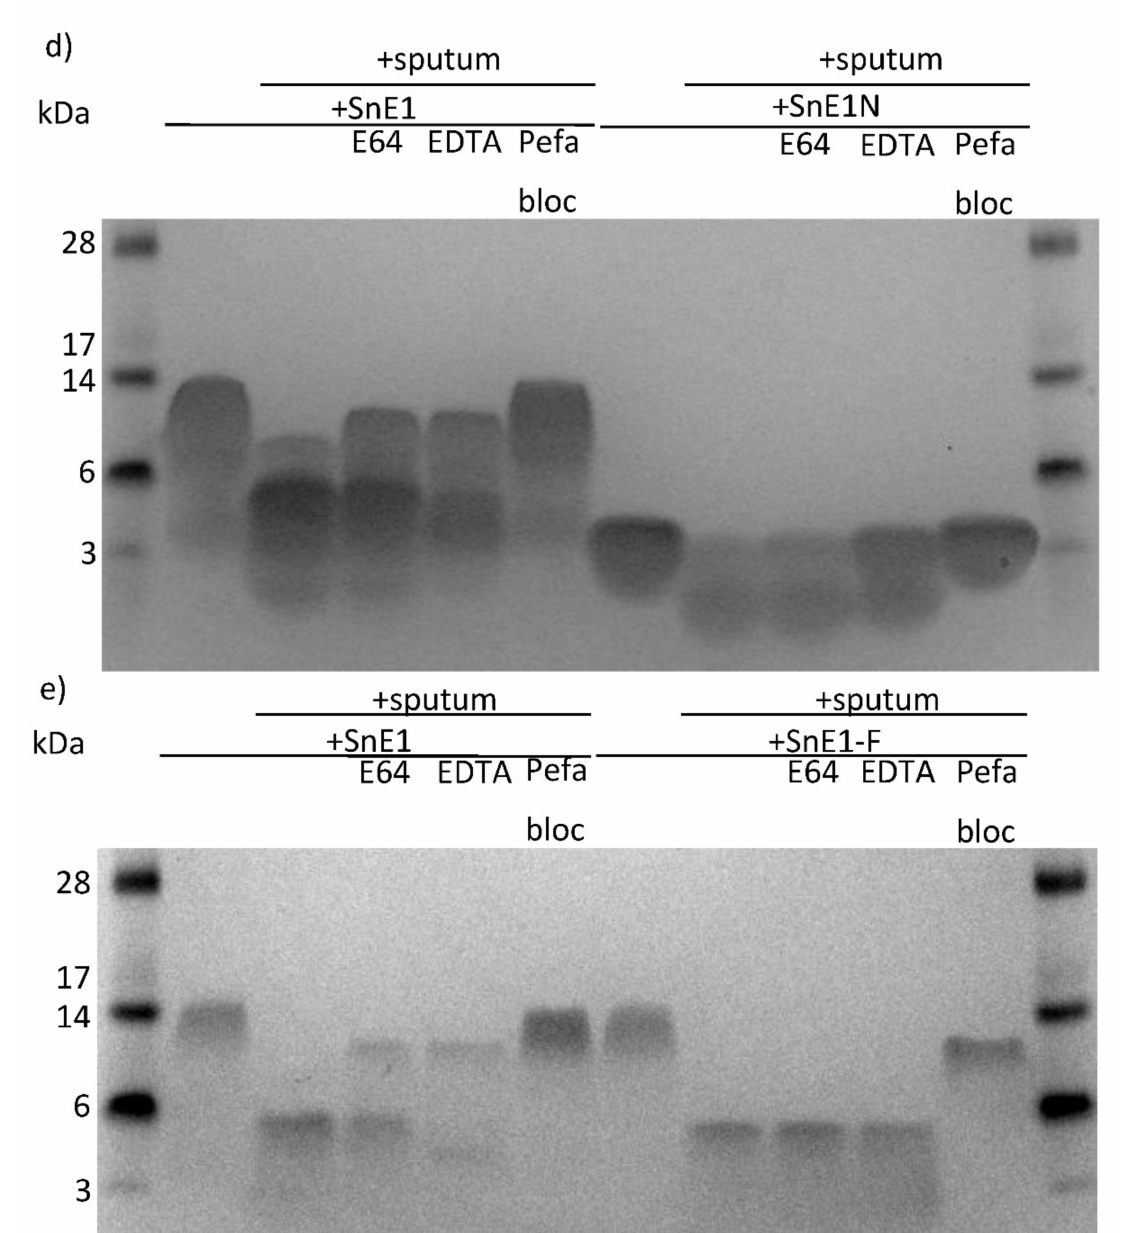
Figure 7. SDS-PAGE gels of next generation peptides following incubation with CF sputum in the presence/absence of protease inhibitors. ( a ) Sn1b, Sn1bN (160 µ M), ( b ) SnE1, SnE1N (120 µ M), ( c ) SnE1 and SnE1-F (120 µ M) were incubated with CF sputum with/without E64, EDTA or pefabloc for four hours. ( d ) SnE1, SnE1N (120 µ M), ( e ) SnE1 and SnE1-F (120 µ M) , were incubated with CF Scheme 64. EDTA or pefabloc for 24 h. Samples were electrophoresed and stained with Coomassie stain for visual